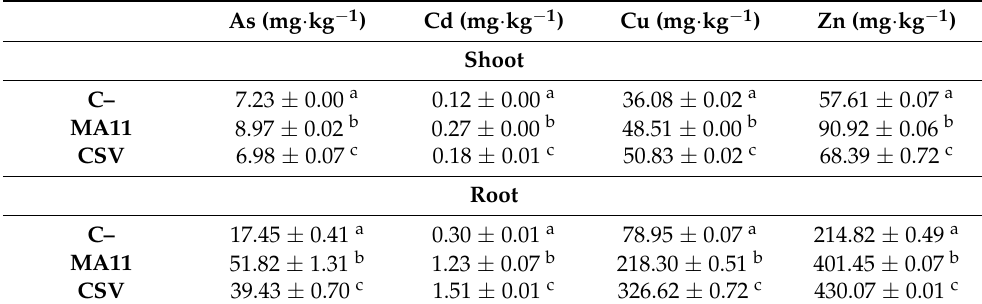
Values are means ± S.D. ( n = 16). Different letters indicate means that are significantly different from each other (one-way ANOVA; LSD test p < 0.0001). C–: non inoculation; MA11: inoculation with E. medicae MA11; CSV: inoculation with V. gossypii JM-310 T , V. paradoxus S110 T , and E. medicae